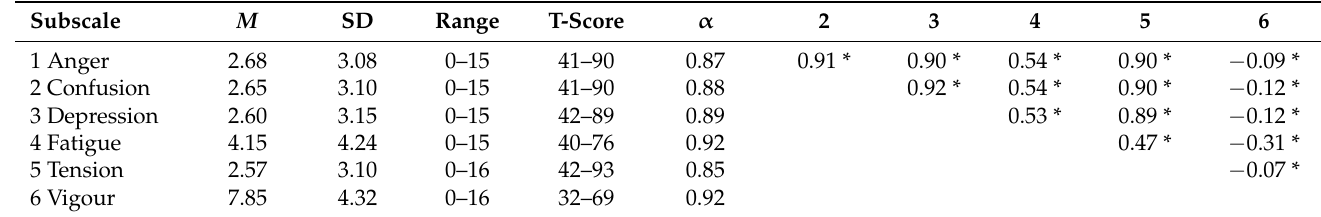
Table 3. Descriptives, reliabilities and intercorrelations among MASMS subscales ( n = 4923).